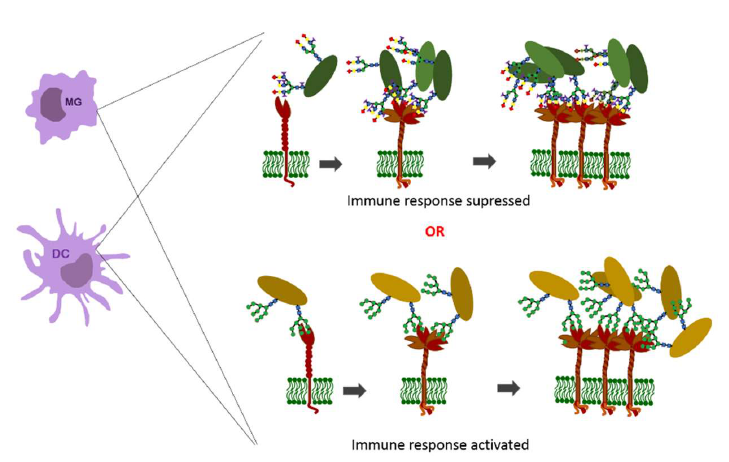
Figure 3. DC-SIGN presented on immune cells, their assembly in the cell membrane, and ligand binding.